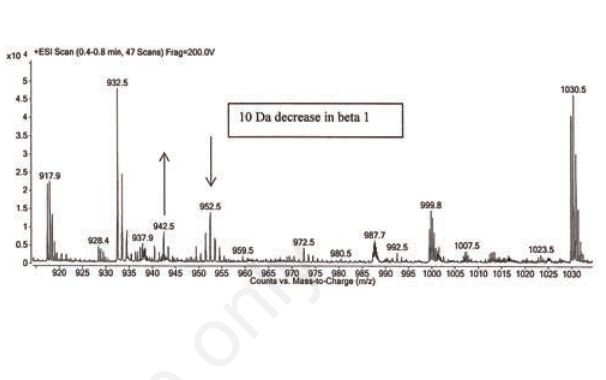
Figure 2. Transformed mass spectra of whole lysate (top) and redissolved isopropanol precipitate (bottom) from patient het- erozygous for Hb Tyne showing normal (15,867 Da) and variant (15,827 Da) chains. The precipitate is enriched with 15,857 Da chains confirming instability. β